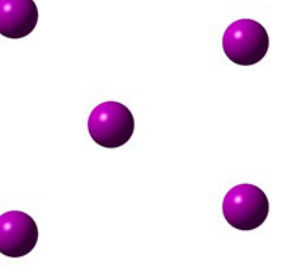
Figure 1. Layer of iodine from the orthorhombic crystal.